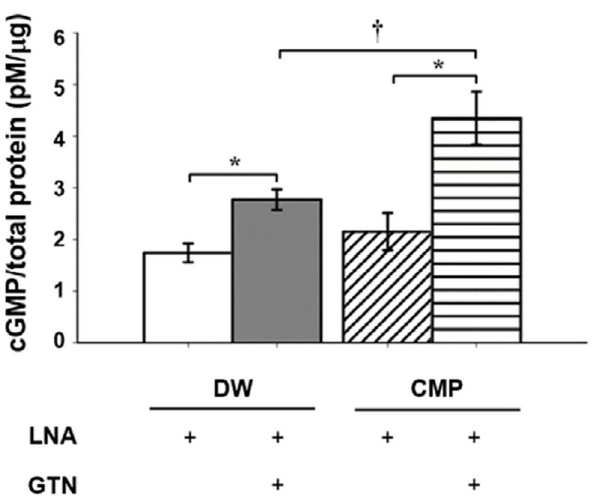
FIGURE 9 - Effects of CMP (1 g/kg) or distilled water (DW, control) consumption by the middle-aged male rats on blood vessel cGMP level. * Significantly higher than their corresponding control, and † significantly higher than the DW control group, P < 0.05.